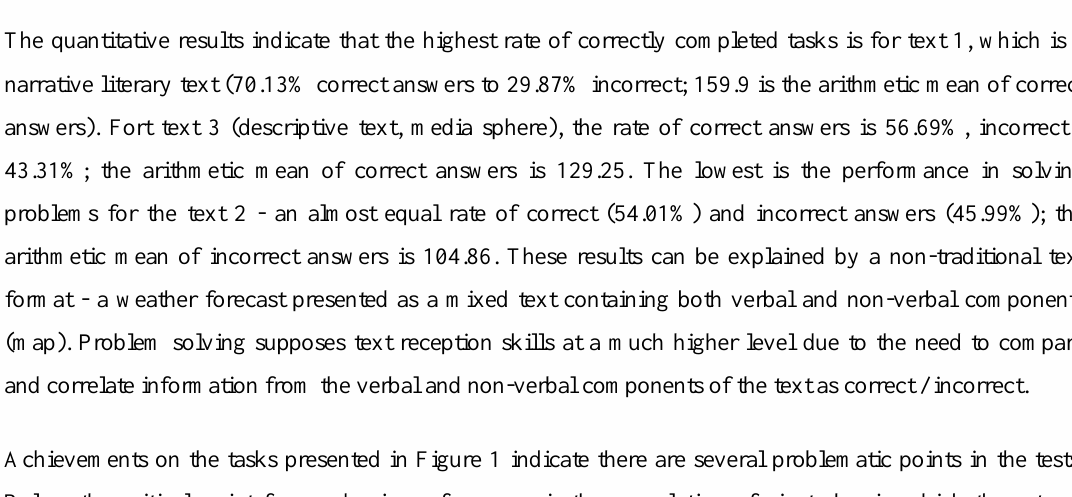
Figure 1. Results of all test